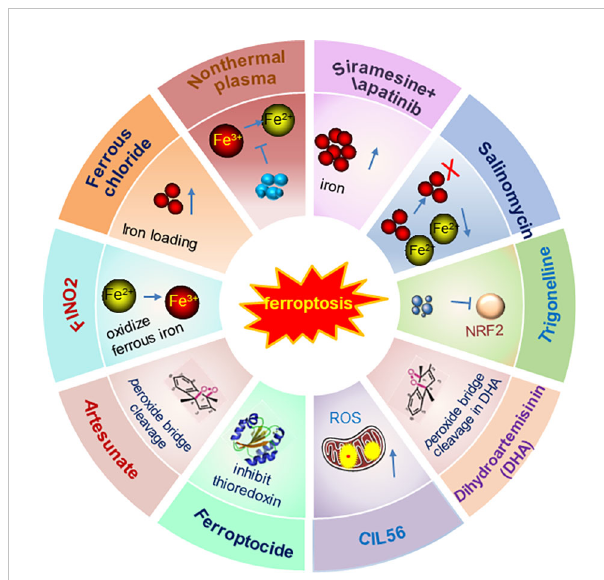
FIGURE 4 Schematic illustration offerroptosis inducers targeting iron overloading. The developed ferroptosis inducers and their functional mechanisms were illustrated in the fi gure. And these ferroptosis inducers are designed mainly to target the iron overloading pathway. Not all the currently reported small molecules were listed in the fi gure and only one of the ferroptosis inducers was illustrated in the fi gure as a representative of each kind of inducers. Modi fi ed according to (48).